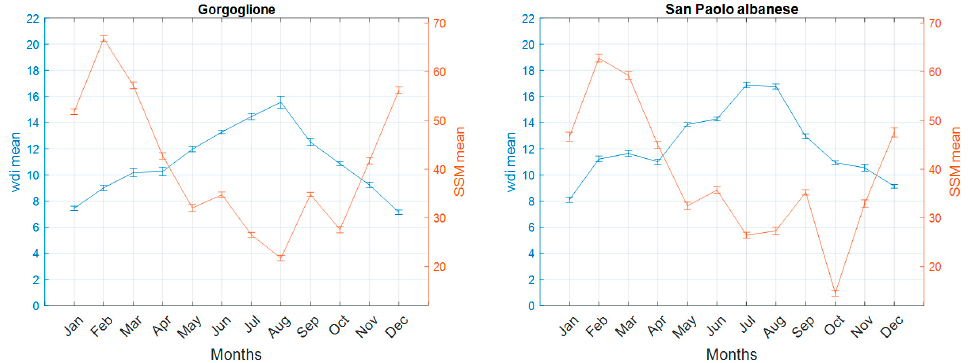
Figure 10. Monthly time series of ssm and wdi in 2017 for the two-tower stations of Gorgoglione ( left ) and S. Paolo Albanese ( right ). Data points are the mean values from a circle of diameter 0.1° around the stations. The error bars represent the variability (standard deviation) of the samples.